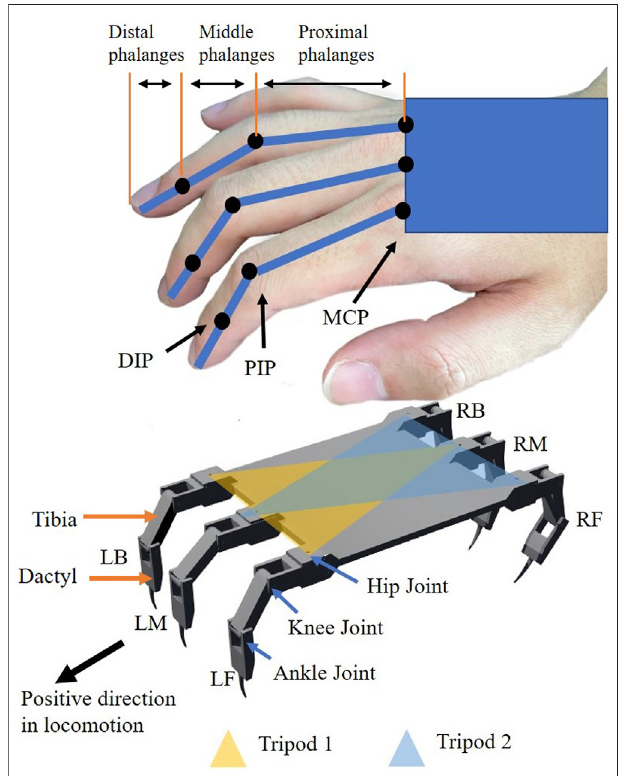
FIGURE 3 | The joints in a hand (above) are mapped with kinematics to control the legs of a hexapod robot (below). Legs are divided into two groups to perform tripod gait in sideways walking. Left-Front leg (LF), Left-Back leg (LB) and Right-Middle leg (RM) are in Tripod 1. Right-Front leg (RF), Right-Back leg (RB) and Left-Middle leg (LM) are in Tripod